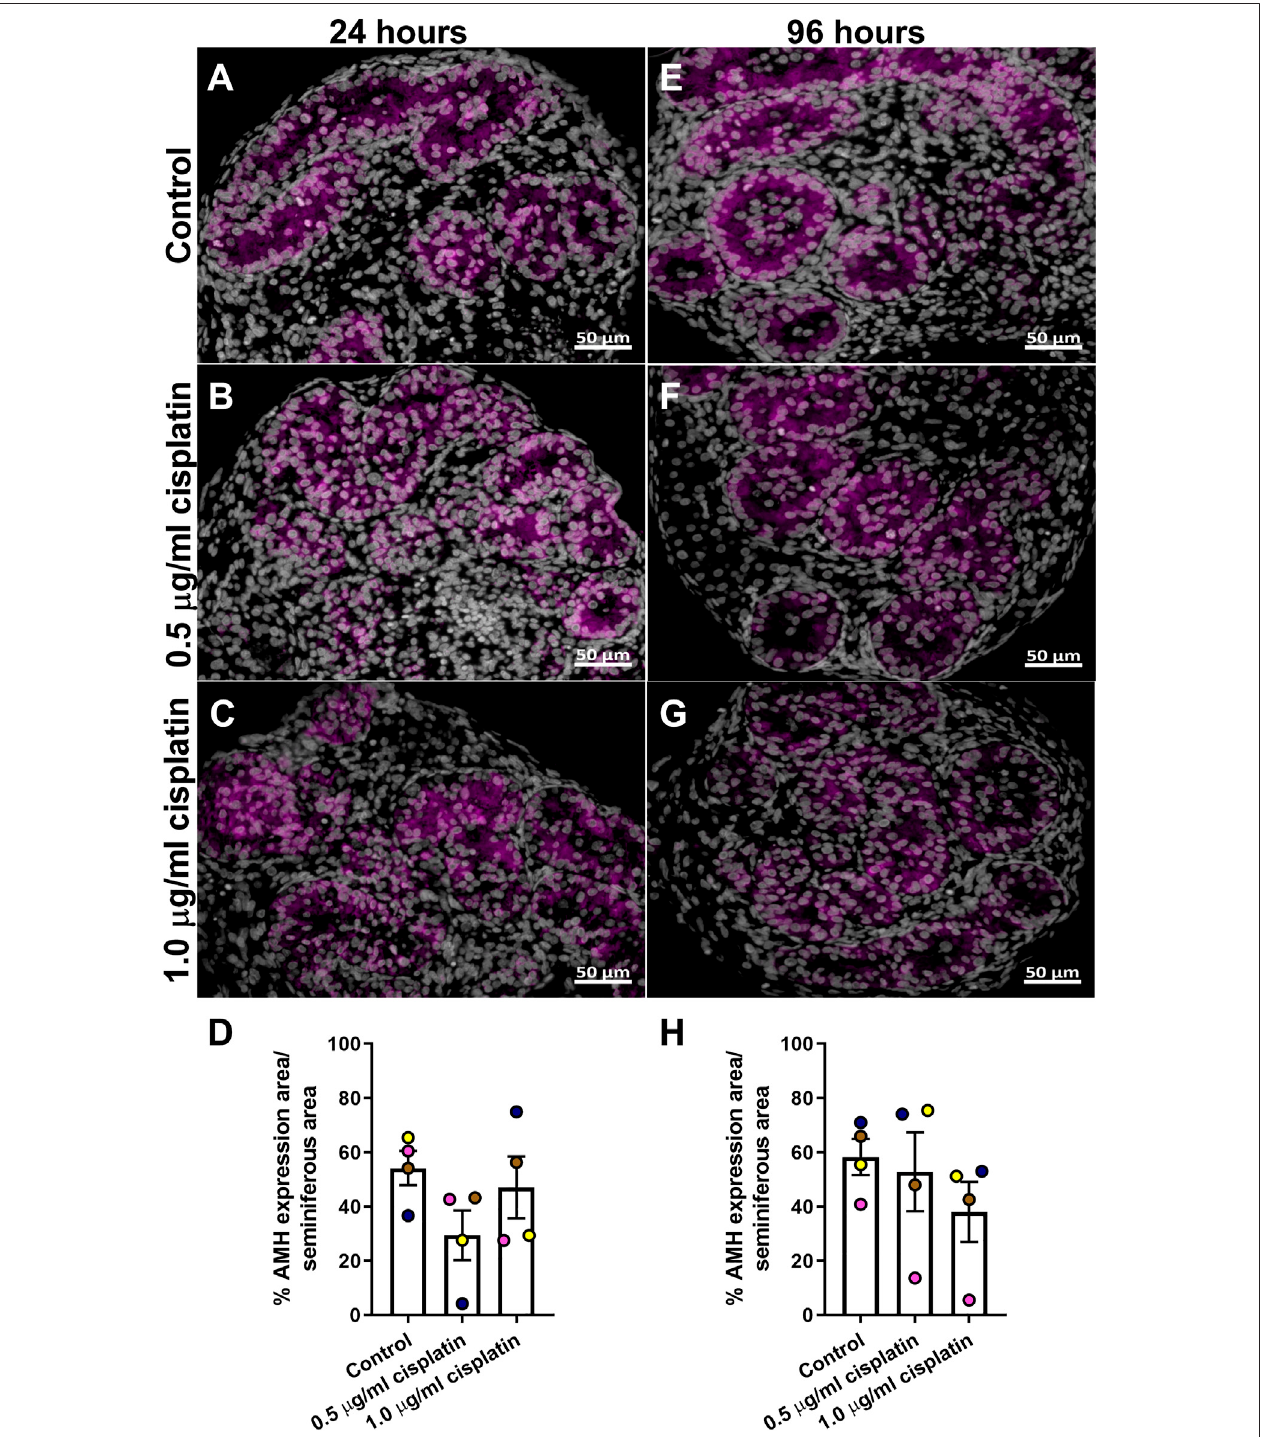
FIGURE 3 | Acute effects of exposure to cisplatin on Sertoli cell maturation in the human fetal testicular tissues. Anti-M ϋ llerian hormone (AMH; purple) protein expression in the human fetal testicular tissues exposed to vehicle control (A,E) , 0.5 μ g/ml cisplatin (B,F) or 1.0 μ g/ml cisplatin (C,G) for 24 h and further cultured until 24 (A – C) and 96 (E – G) hrs post-exposure. Scale bars represent 50 μ m. Quanti fi cation of percentage of cord area expressing AMH (D,H) . Exposure to cisplatin did not haveanacuteeffectonthepercentageofcordareaexpressingAMH.Dataanalysedusingtwo-wayANOVA.Valuesshownaremeans±SEMandeachofcoloured data points represents an individual fetus ( n =